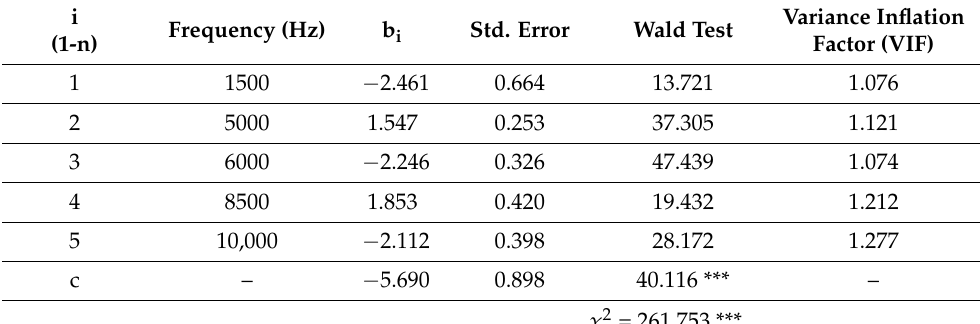
Table 3. Fit of Model 5 eggshell crack calibration curve for the prediction of eggshell cracks.